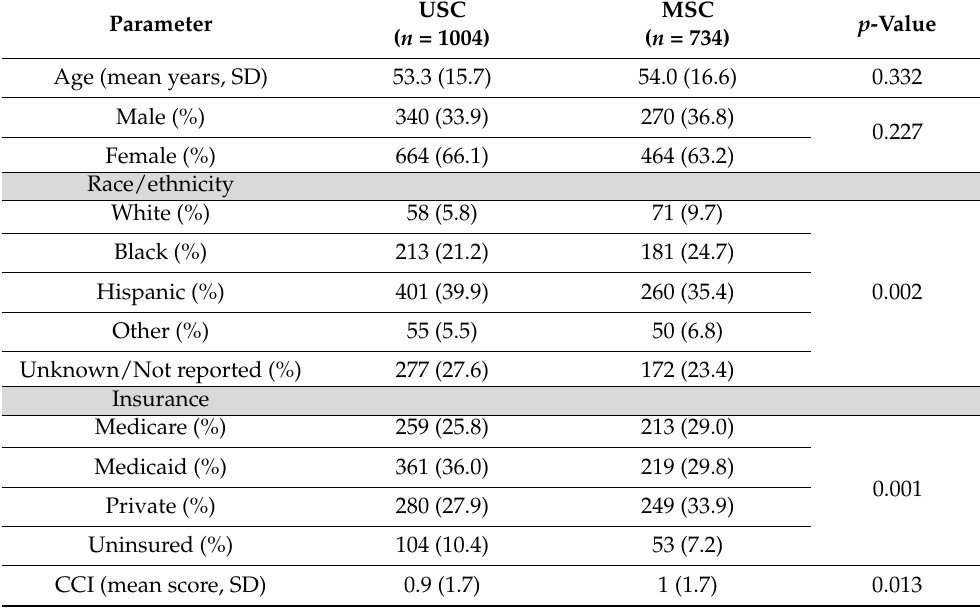
Table 1. Baseline and socioeconomic characteristics of all patients presenting with back and/or leg pain to the Unidisciplinary Spine Clinic (USC) and Multidisciplinary Spine Clinic (MSC). Parameter